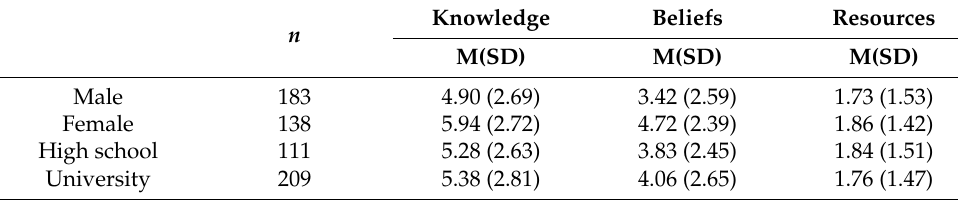
Table 4. Mental Health Literacy scores by